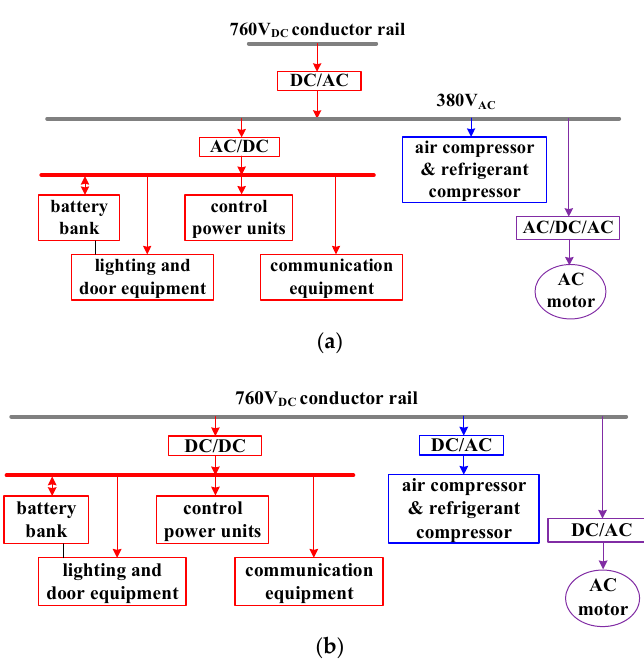
Figure 2. Light rail transit. ( a ) Block diagram of the power distribution in a conventional light rail vehicle; ( b ) block diagram of the power distribution in the studied light rail vehicle.